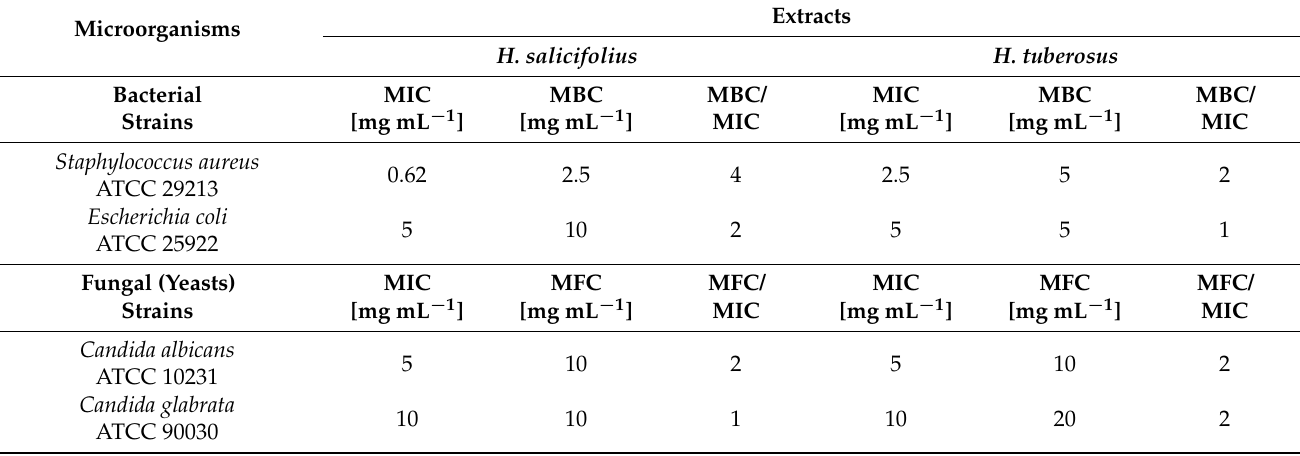
Table 3. Antimicrobial activity of supercritical extracts obtained from H. salicifolius and H. tuberosus with water as a co-solvent (CO 2 + H 2 O